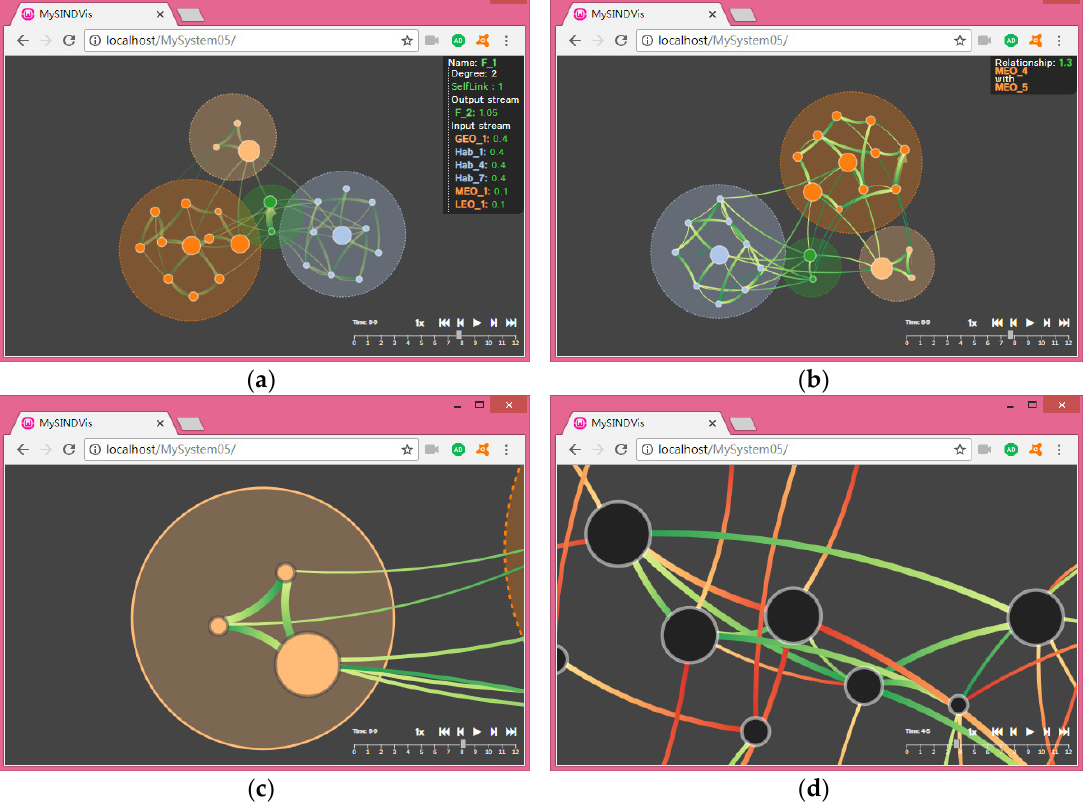
Figure 17. Interactive function displays of the SIN TopolView: ( a ) the interactions between the user and the node; ( b ) the interactions between the user and the edge; ( c ) the translation interaction function; and ( d ) the zoom interaction function.